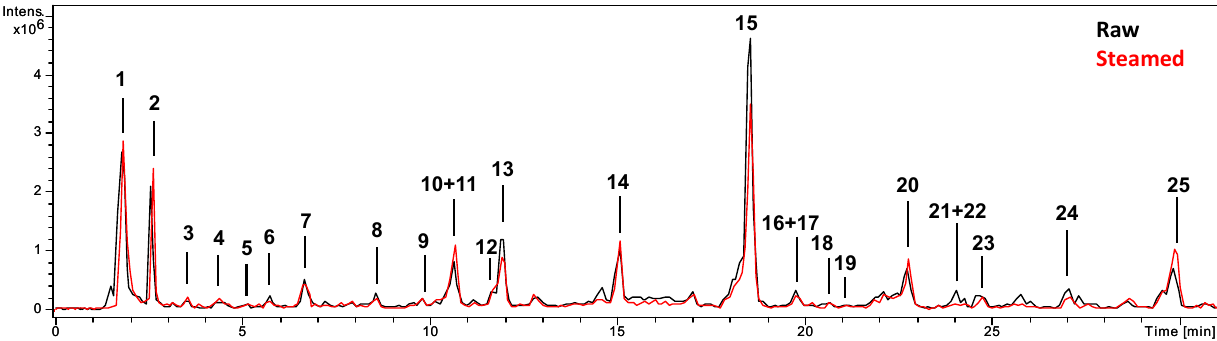
Figure 3. HPLC-ESI/MS n base peak chromatograms (BPC) of the raw and steamed extracts of Portulaca oleracea aerial parts.